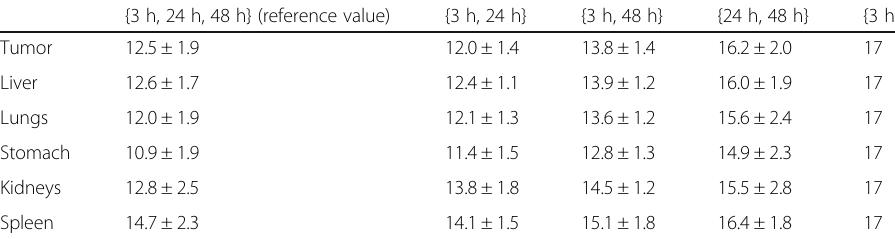
Table 3 Effective half-lives of tumors and organs at risk determined using patient imaging data at {3 h, 24 h, 48 h},{3 h, 24 h}, {3 h, 48 h}, and {24 h, 48 h}. The data is compared to an effective half-life of 17 h (which would assume that AHDD-Lipiodol biological half-life is infinity, as in Zanzonico et al 2008 [29]). The data are presented as the average effective half-life across all patients ± SD in hours {3 h, 24 h, 48 h} (reference value) {3 h, 24 h} {3 h, 48 h}